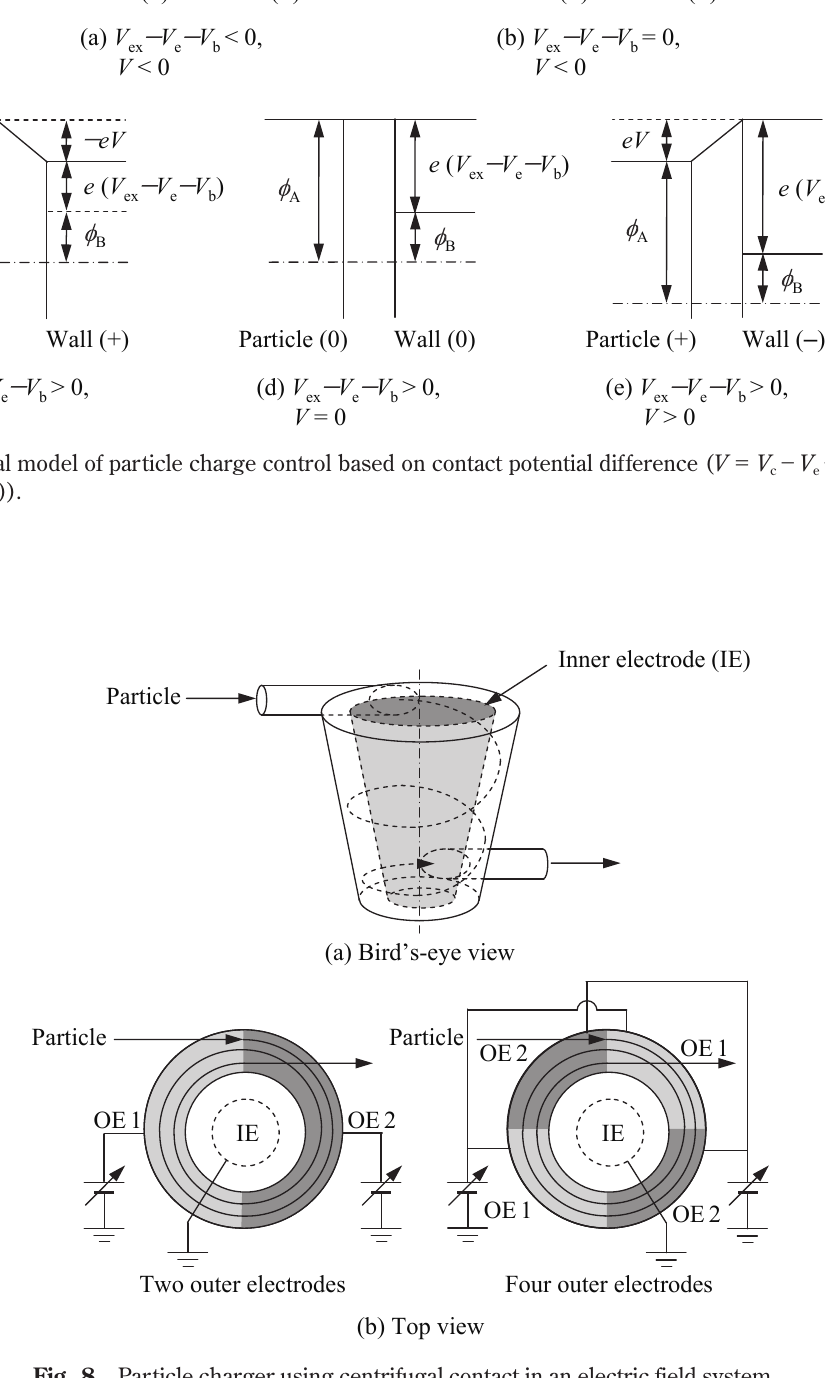
Fig. 8 Particle charger using centrifugal contact in an electric field system.